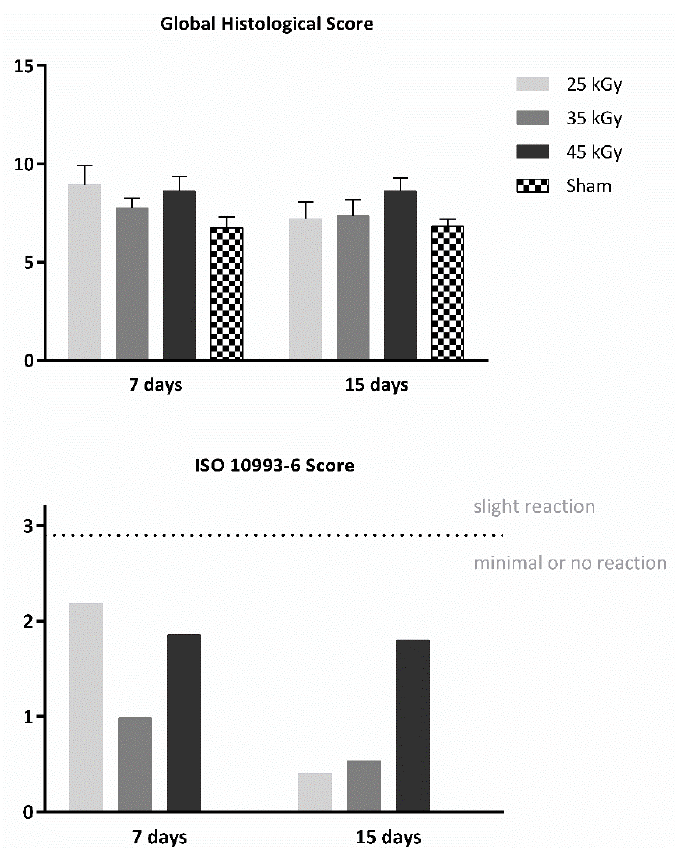
Figure 7. Global histological score (upper panel) and calculated score, according to guideline ISO 10993-6:2016 (lower panel), for subcutaneous implantation (biocompatibility assessment) of the PCL devices, 7 and 15 days after implantation time. Table 2. Global histological scores presented as mean ± SE following ISO-10993-6 guidelines for the PCL devices groups and sham, at 7 and 15 days after implantation.